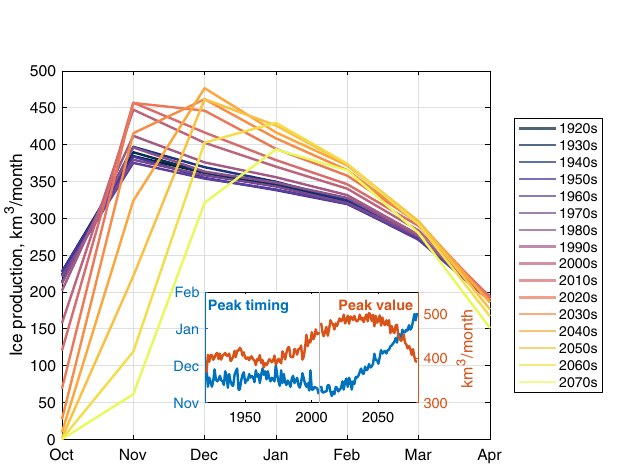
Fig.3|Changingwintercyclesoficeproduction. Decadalensemblemeanseaice production through winter months in CESM-LE. Inset panel shows changes in the timing of peak sea ice production and changes in the amplitude of the peak value. Note that the peak timing is interpolated using the mean of the 40 monthly reso- lution values from individual ensemble